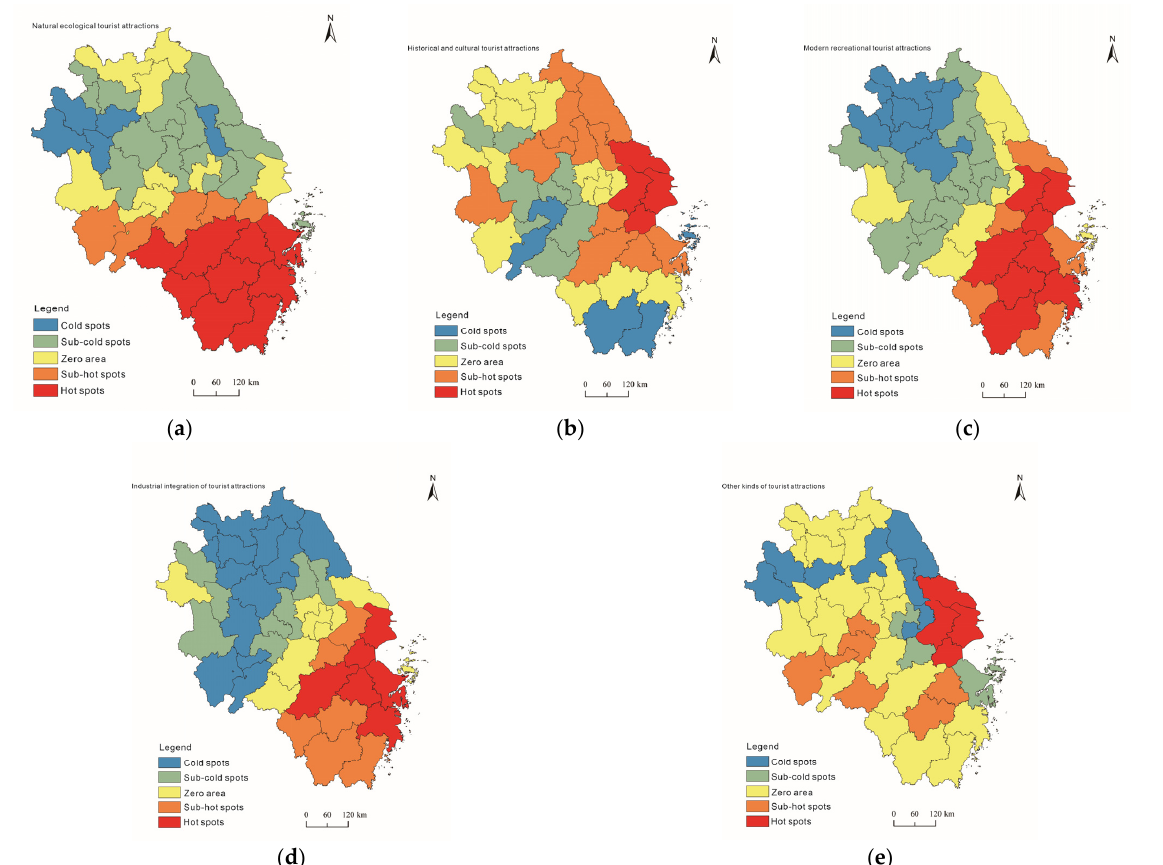
Figure 4. Distribution of hot spots in the five types of tourist attractions: ( a ) Natural ecological tourist attractions; ( b ) Historical and cultural tourist attractions; ( c ) Modern recreational tourist attractions; ( d ) Industrial integration of tourist attractions; and ( e ) Other kinds of tourist attractions.